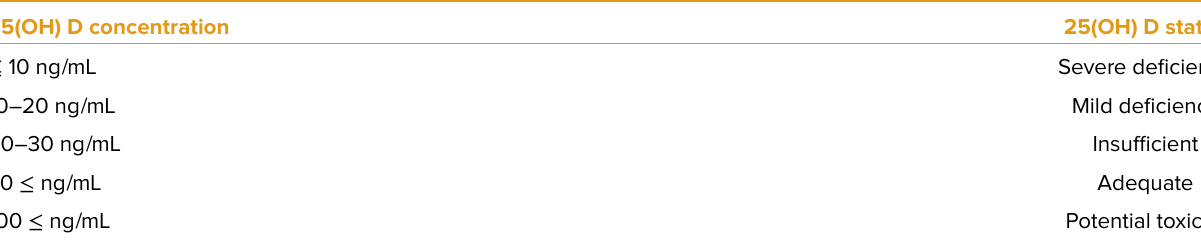
Table 2. Demographic and clinical characteristics of patients